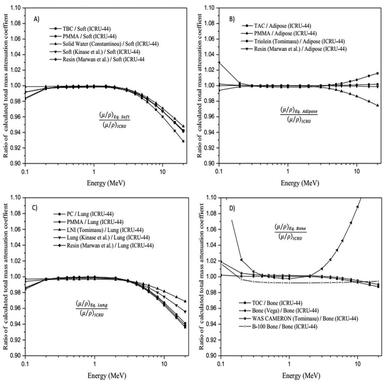
TMAC normalization of: (A) the substitute materials with respect to soft tissue of ICRU. (B) The equivalent materials with respect to adipose tissue of ICRU. (C) The equivalent materials with respect to the ICRU lung. (D) The equivalent materials with respect to cortical bone of ICRU-44. All the equivalent materials were normalized without taking into account the hydrogen in the energy range from 0.1 MeV to 20 MeV.